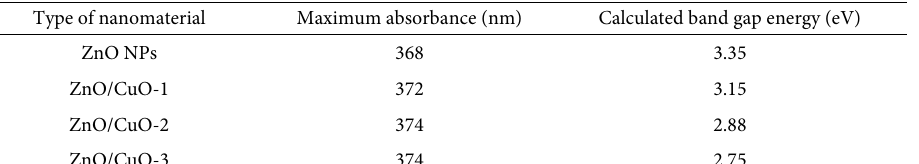
Table.2. Optical parameters for prepared samples